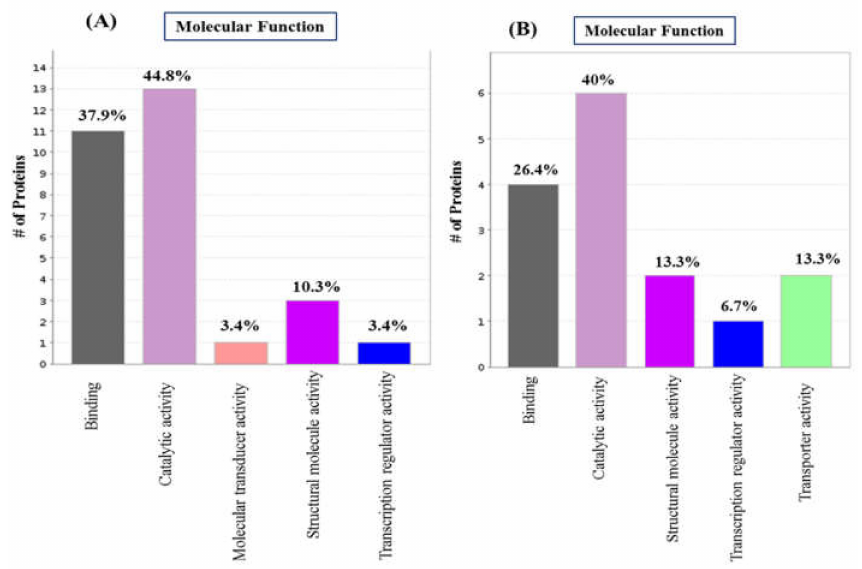
Figure 2. Classification of the unique/exclusive differentially regulated proteins of 3dwb and 12dwb based on their functional annotations using Gene Ontology. ( A ) GO Molecular Function for 3dwb; ( B ) GO Molecular Function for